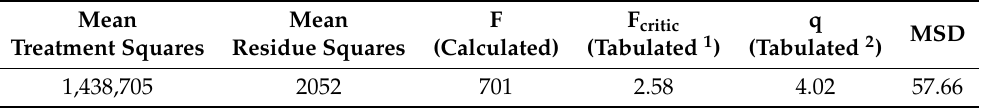
Table 13. ANOVA and Tukey’s test parameters for shear wave velocity. Mean Treatment Squares